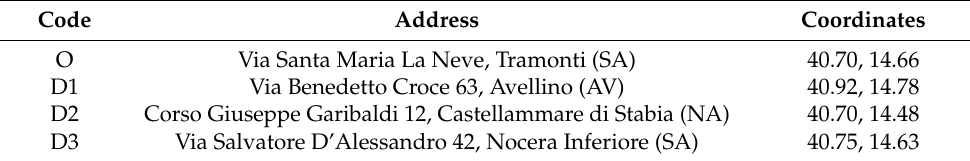
Table 2. List of locations considered for the trips. All locations are in Campania, Italy.